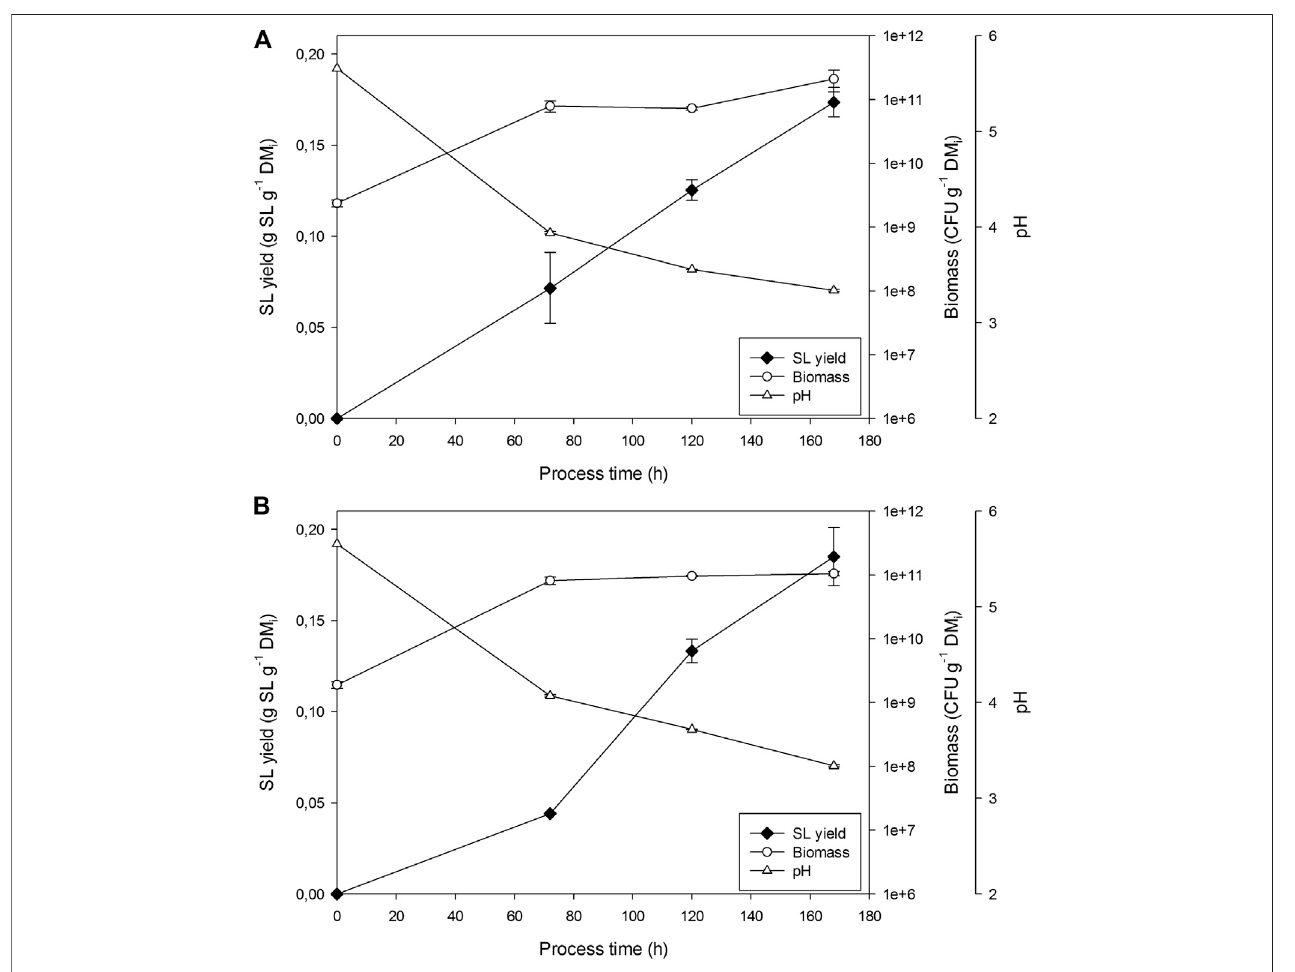
FIGURE 1 | Sophorolipids, pH and CFU evolution in fermentations in R22 for (A) replicate 1 and (B) replicate 2.